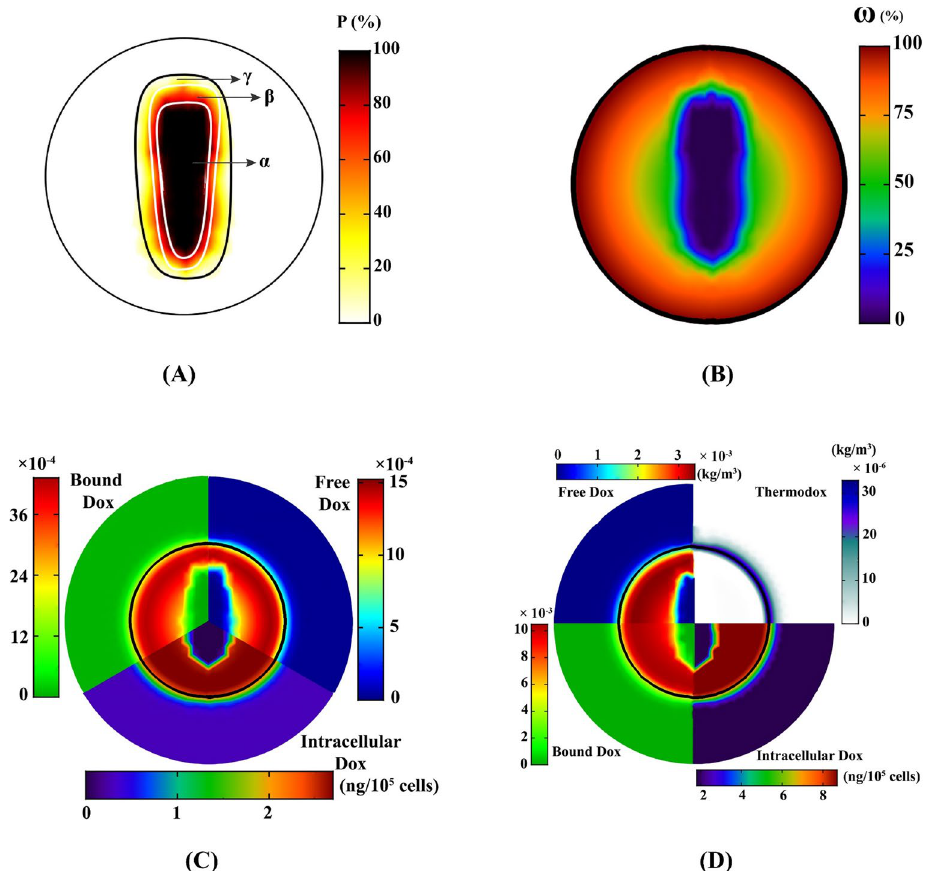
Figure 6. Ablation and medication therapy; ( A ) Thermal ablation forms three regions: coagulative necrosis (α), sublethal necrosis (β), and the region in which cells are not affected (γ). ( B ) Perfusion damage due to thermal ablation; the perfusion is zero in the α region, the perfusion yield is less than 25% in the β region, and the perfusion yield is half in the γ region. This contour indicates perfusion and vascular density. ( C ) Spatial distribution of the drug in the combination of thermochemotherapy and thermal ablation. ( D ) Spatial distribution of the therapeutic agents in the combination of ThermoDox therapy and thermal